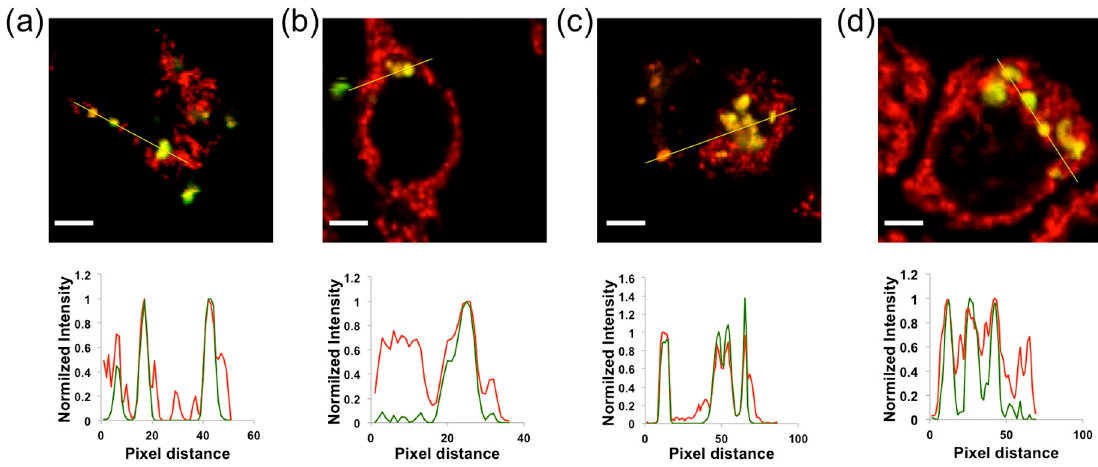
Figure 2. Representative colocalization images, selected from a set of at least 15 different images in each case, of the QD-SS20-MPA nanosensors (green channel) and the MT staining dye (red channel) in 143B osteoblasts ( a ), and MCF7 ( b ), MDA-MB-231 ( c ), and MDA-MB-468 ( d ) breast cancer cells. The intensity profiles correspond to the yellow lines drawn in the images. The scale bars represent 10 µm.